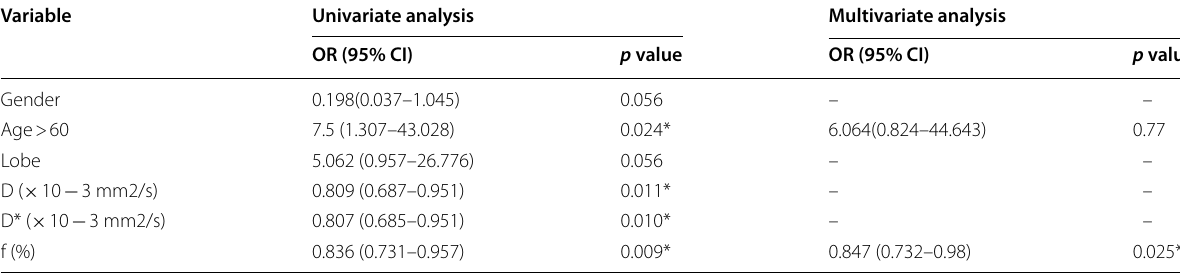
The multivariate model was adjusted for age at recruitment (> 60 or